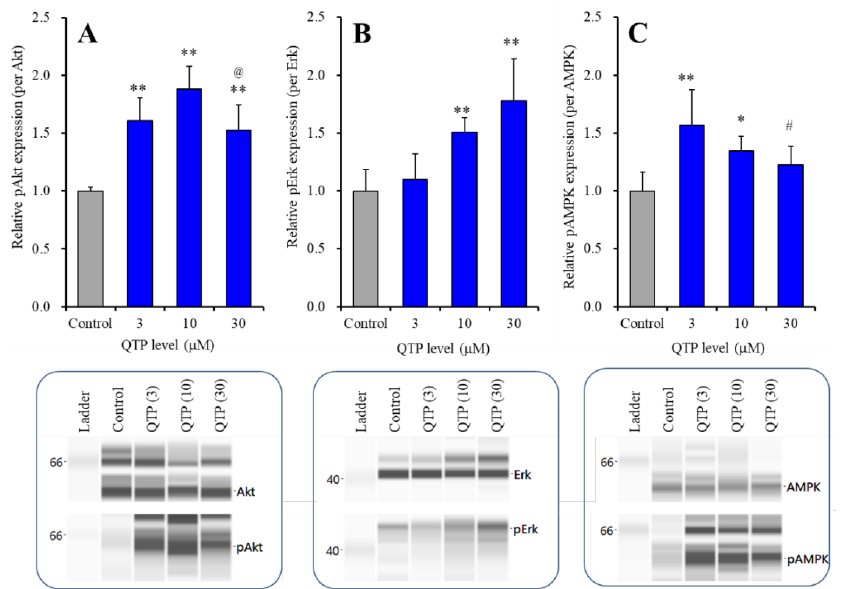
Figure 4. Concentration-dependent effects of subchronic administration (7 days) of QTP on protein expression of pAkt ( A ), pErk ( B ) in the plasma membrane fraction and pAMPK ( C ) in the cytosol fraction of cultured astrocytes. In upper side histograms, ordinate: mean ± SD (n = 6) of the relative protein level of pAkt, pErk and pAMPK per Akt, Erk and AMPK, respectively. Abscissa: QTP level ( µ M). * p < 0.05, ** p < 0.01: relative to control (QTP free), @ p < 0.05: relative to 10 µ M QTP in panel A; # p < 0.05: relative to 3 µ M QTP in panel C by one-way ANOVA with Tukey’s post-hoc test. Lower side panels indicate their pseudo-gel images, using capillary immunoblotting.